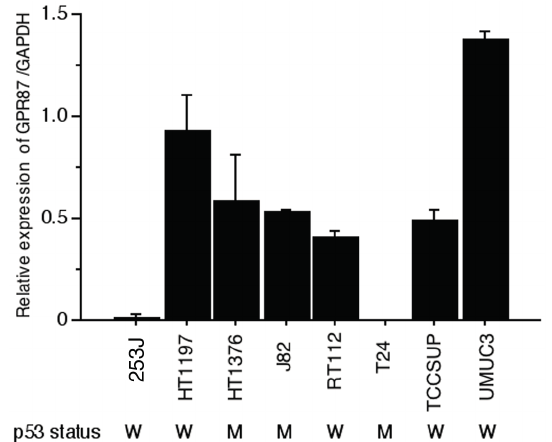
Figure 1. GPR87 gene expression and p53 status in eight human bladder cancer cell